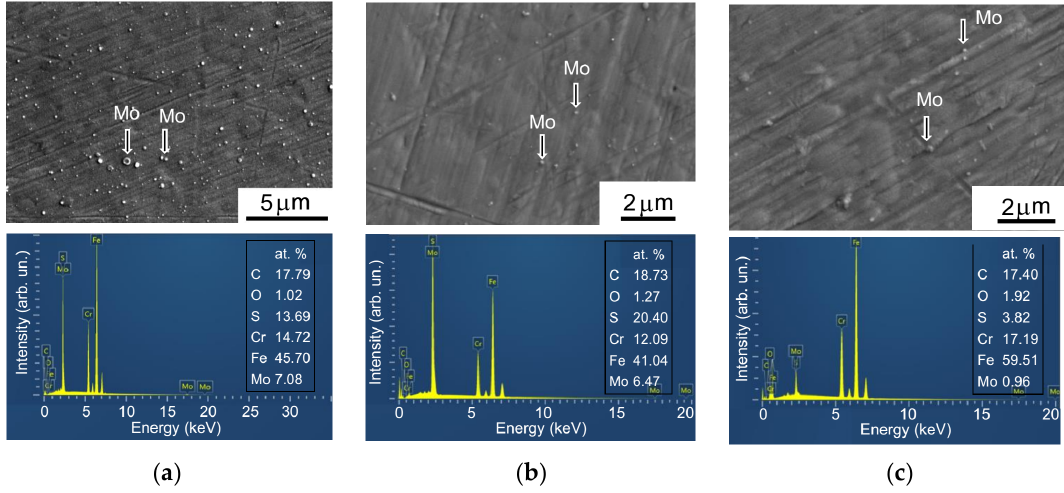
Figure 1. SEM images and energy-dispersive X-ray spectroscopy (EDS) spectra of MoS x thin-film coatings, obtained through reactive pulsed laser deposition (RPLD) on steel disks in H 2 S gas at pressures of ( a ) 8 Pa, ( b ) 16 Pa, and ( c ) 29 Pa. EDS spectra were measured in a 10 × 10 µ m 2 area. The arrows indicate the Mo particles that were ejected from the Mo target during pulsed laser ablation.